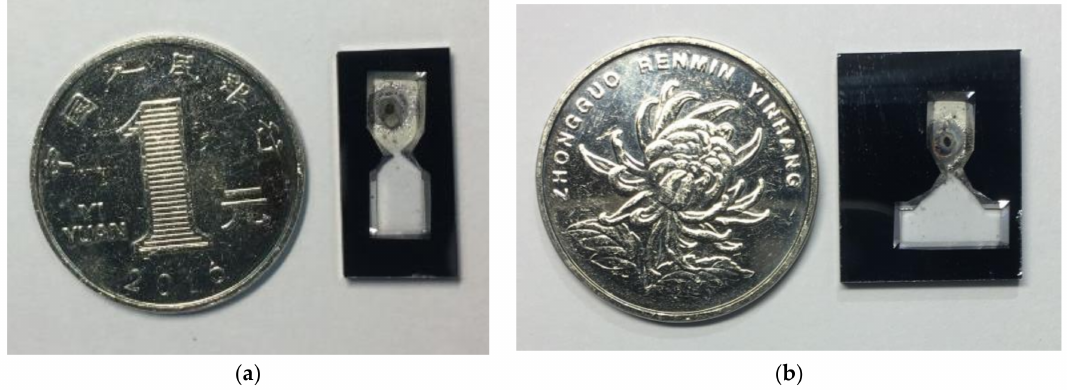
Figure 5. Cell photo of ( a ) 5 mm and ( b ) 10 mm long reflective optical length compared with 1 RMB